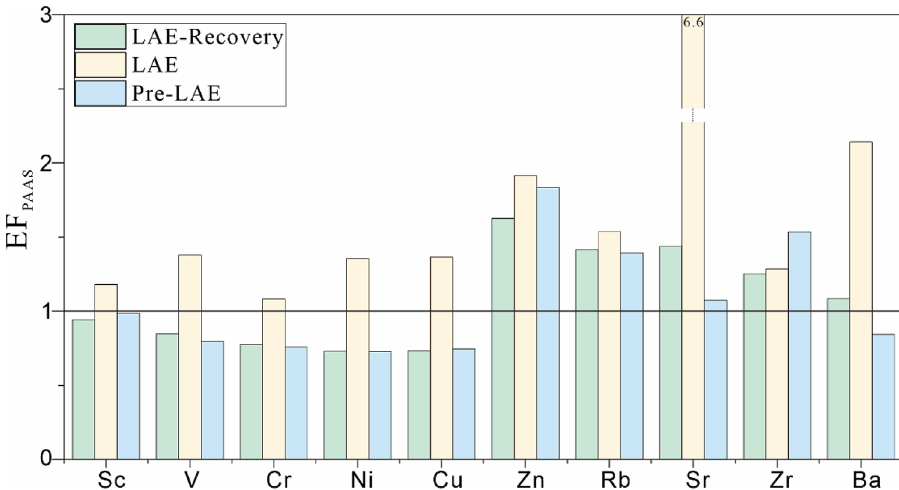
Figure 9. Enrichment factors (EF) results according to post Archean average Australian shale (PASS)